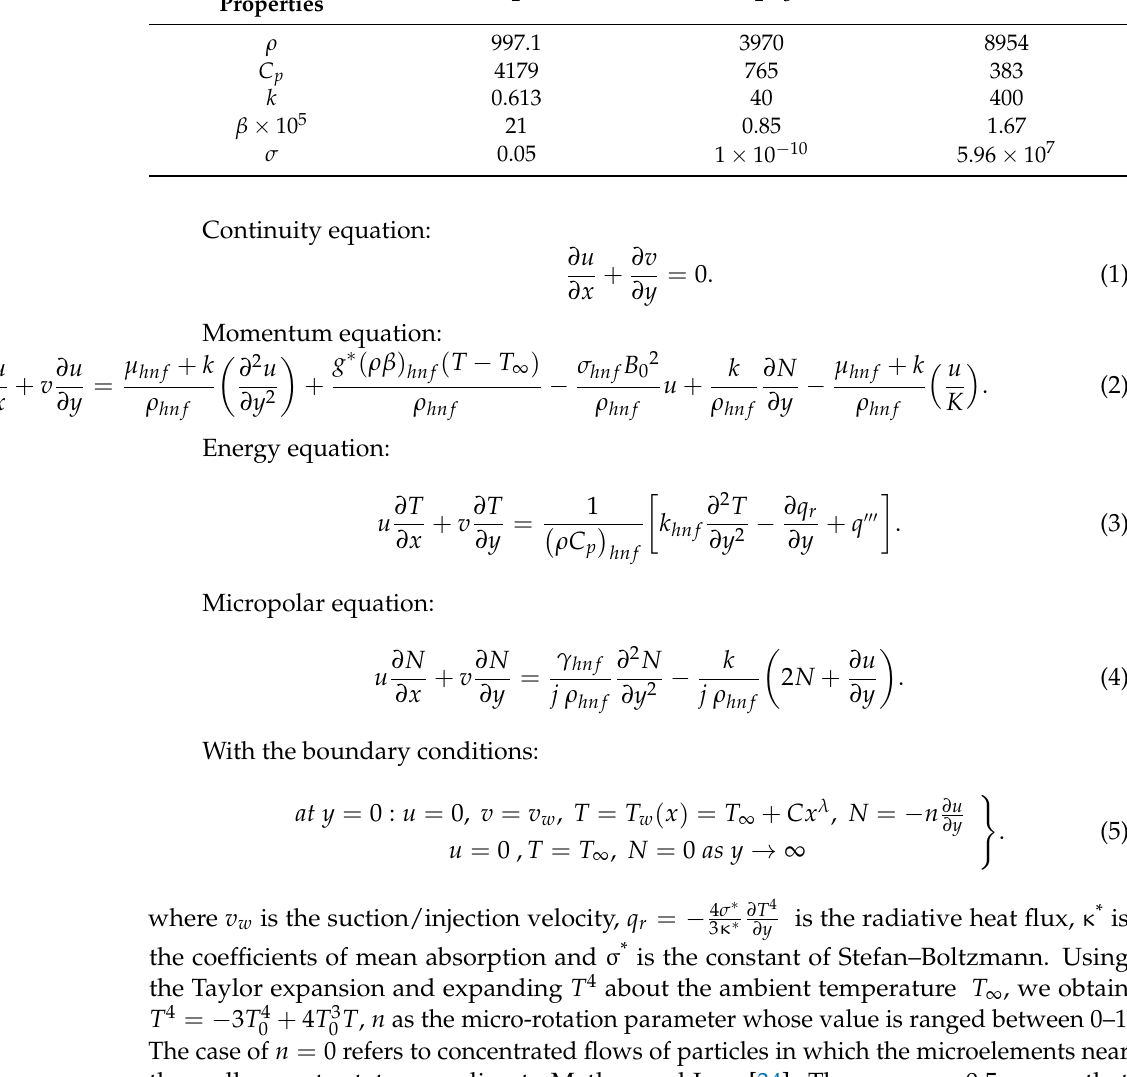
Table 1. Thermophysical properties of water, copper and alumina [30,31].